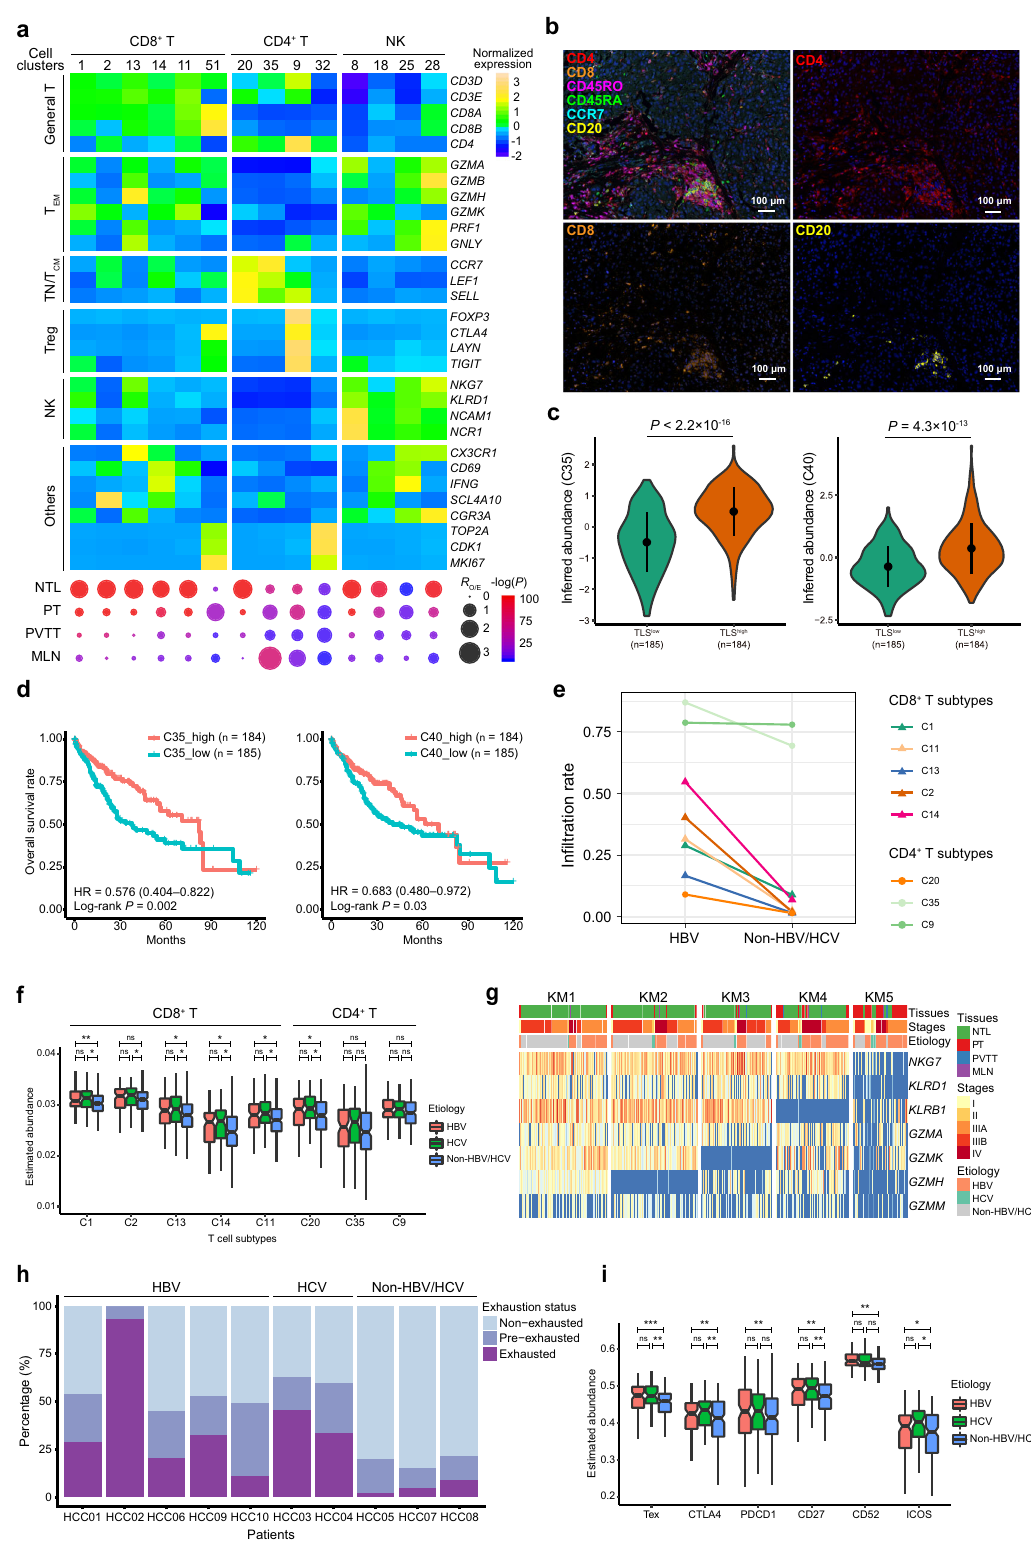
showed heterogeneity across patients, varying from 1.8% to 27.8% (Supplementary Fig. 3b). Among CD4 + T cell subtypes, regulatory T cells (Tregs; C9) were enriched in PT, consistent with previous fi ndings 4,5,11 . However, we identi fi ed another cluster of CD4 + T cells (C35), highly expressing key markers of TN or T CM cells, were speci fi cally enriched in PT and